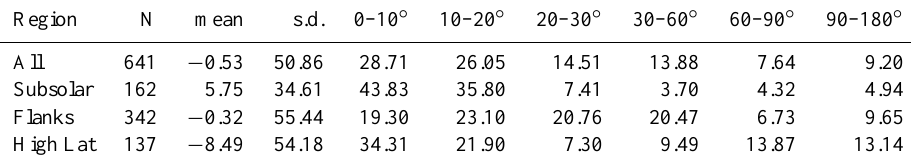
Table 11. Distribution of angular differences in the low pressure case (solar wind dynamic pressure ≤ 2nPa). Format as in Table 3. Region N mean All Subsolar 201 Flanks 0 0.00 0.00 High